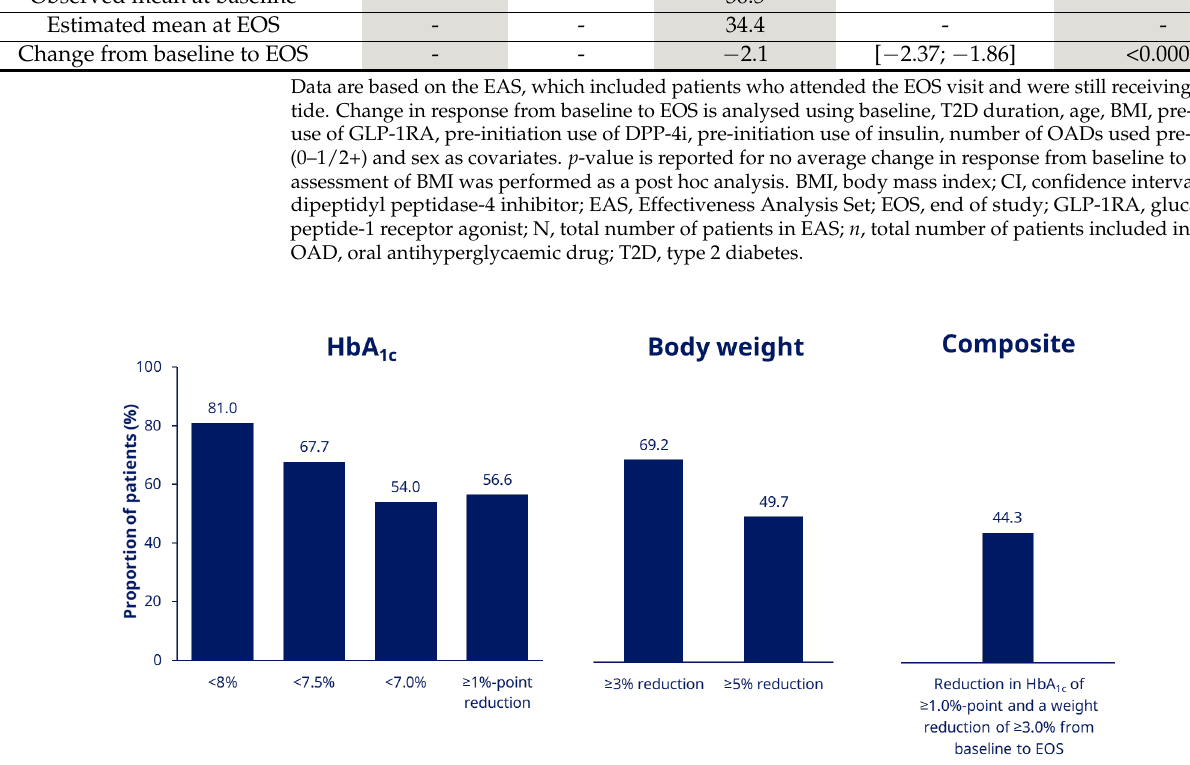
Figure 2. Proportion of patients achieving HbA 1c targets and weight-loss goals (EAS). EAS, Effectiveness Analysis Set; EOS, end of study. Table 2. Change from baseline to EOS in HbA 1c , body weight, waist circumference, and BMI (EAS).